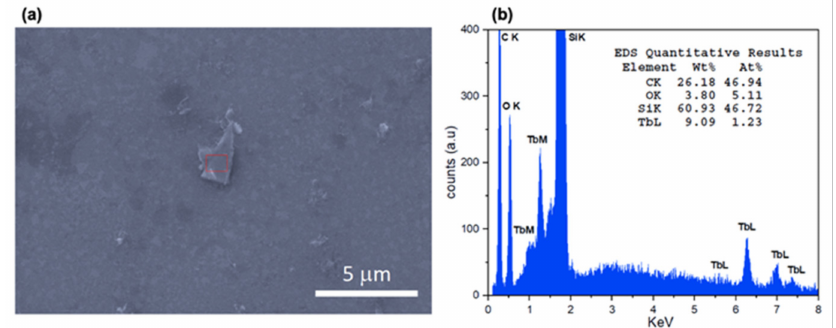
Figure 5. SEM image of a Tb-2D MOF flake deposited on silicon ( a ), and EDS analysis ( b